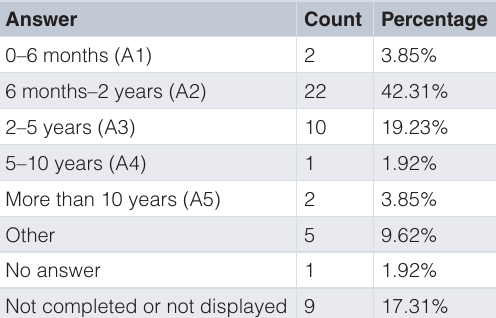
Table 1. Starting hydroxycarbamide therapy in sickle cell disease.